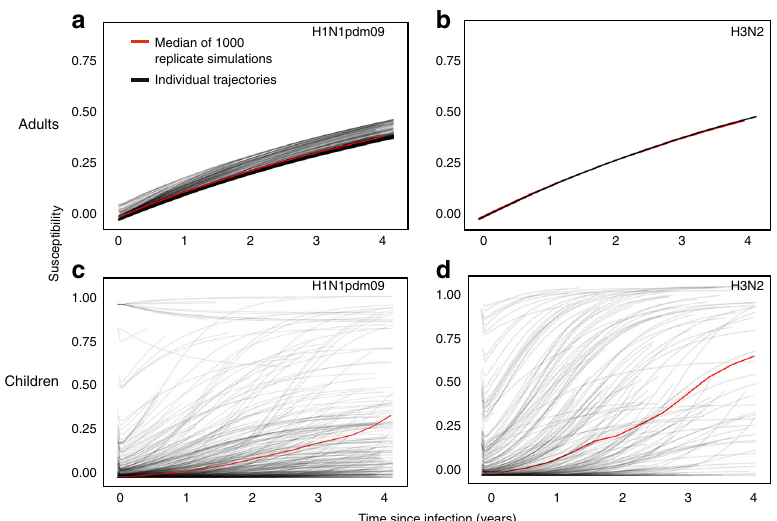
Fig. 2 Susceptibility after simulated infection with H1N1pdm09 and H3N2 in adults and children. Susceptibility is shown after simulated infection (at time t = 0) for adults with H1N1pdm09 ( a ) and H3N2 ( b ) and for children with H1N1pdm09 ( c ) and H3N2 ( d ). The black lines represent individual trajectories from one simulation, and the red line represents the median among individuals over 1000 replicate simulations. Curves from individual trajectories are truncated at points corresponding to the end of the